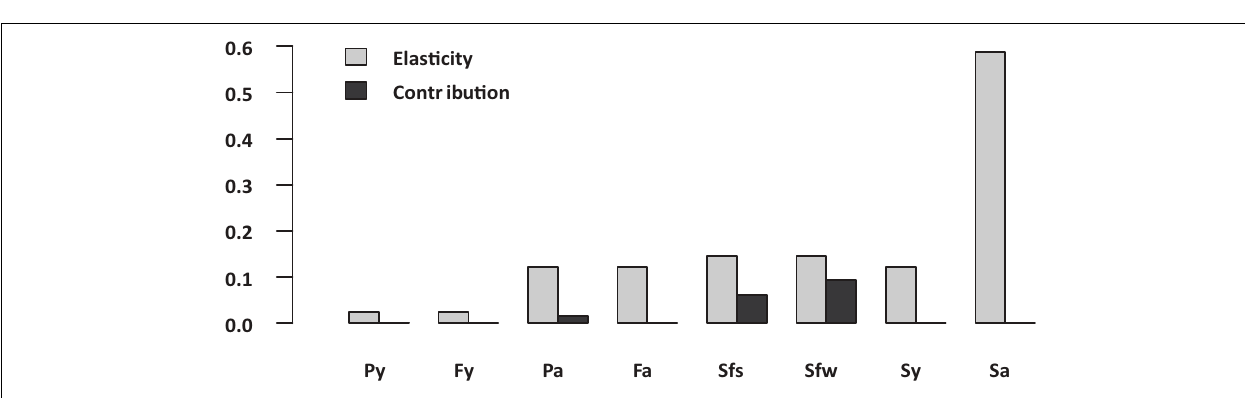
FIGURE 5 | Sitka black-tailed deer vital rate elasticity versus contributions to observed annual variability in asymptotic growth rate, where Py and Fa denotes pregnancy of yearlings and adults, Fy and Fa denoted fertility (females per fawn) of yearling and adults, and Sf(s), Sf(w) , Sy , and Sa denote survival of age classes fawn (days 1–90), fawn (days 91–365), yearling, and adults. The study was conducted 2010–2013, on Prince of Wales Island, AK, United